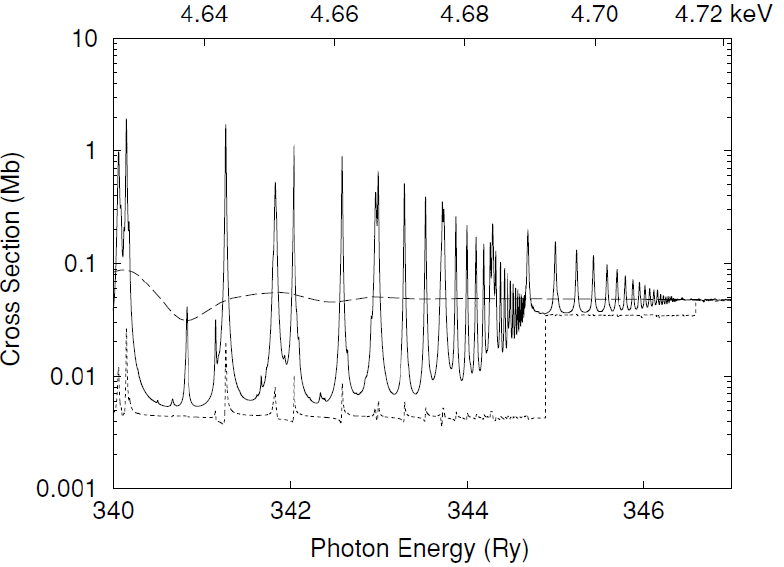
Figure 6. K-edge photoabsorption (full curve) and photoionization (dotted curve) cross-sections of Ca XV (C-like) as a function of photon energy. The dashed curve gives the photoabsorption cross-section convolved with a Gaussian of 0.001 width. Reproduced from Figure 3 of [18] with permission of the